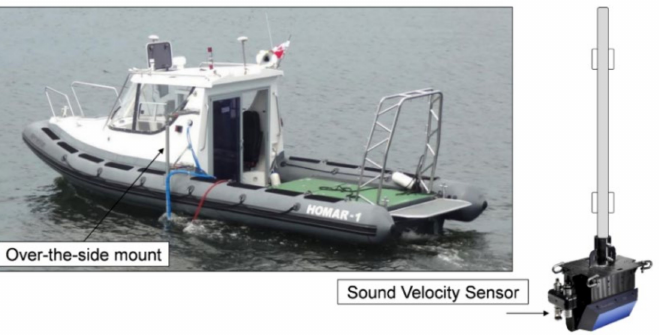
Figure 8. Polish Navy rigid inflatable boat (RIB) equipped with Kongsberg GeoAcoustics GeoSwath Plus echosounder mounted over-the-side.